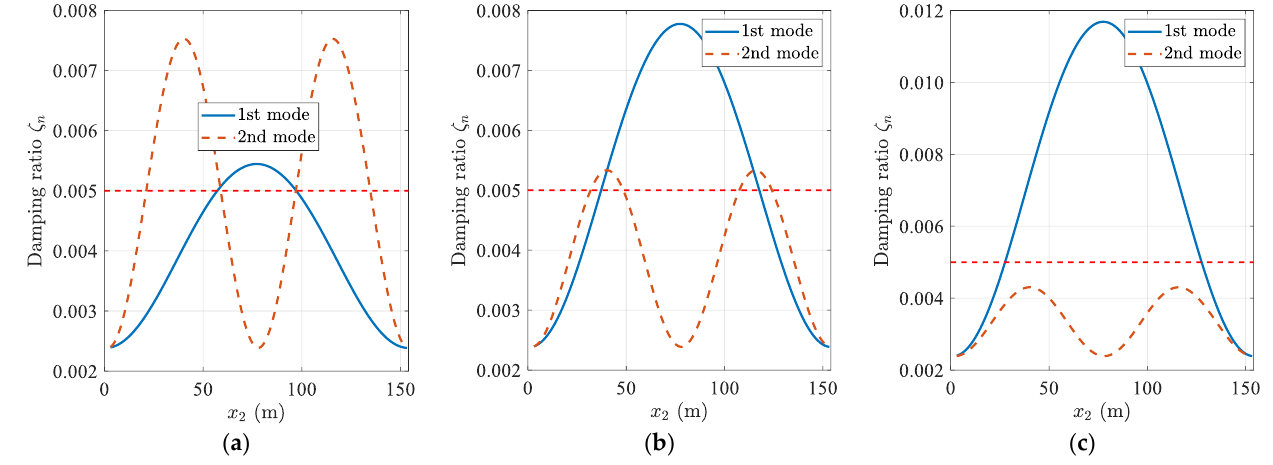
Figure 11. Dampers’ design targeting the first two cable vibration modes ( 𝑀 = 70 kg,𝜑 = 0.5,𝑥 1 /𝐿 = 0.02, ) with different frequency ratios: ( a ) 𝜌 = 0.7 ; ( b ) 𝜌 = 0.8 ; ( c ) 𝜌 = 0.9 .